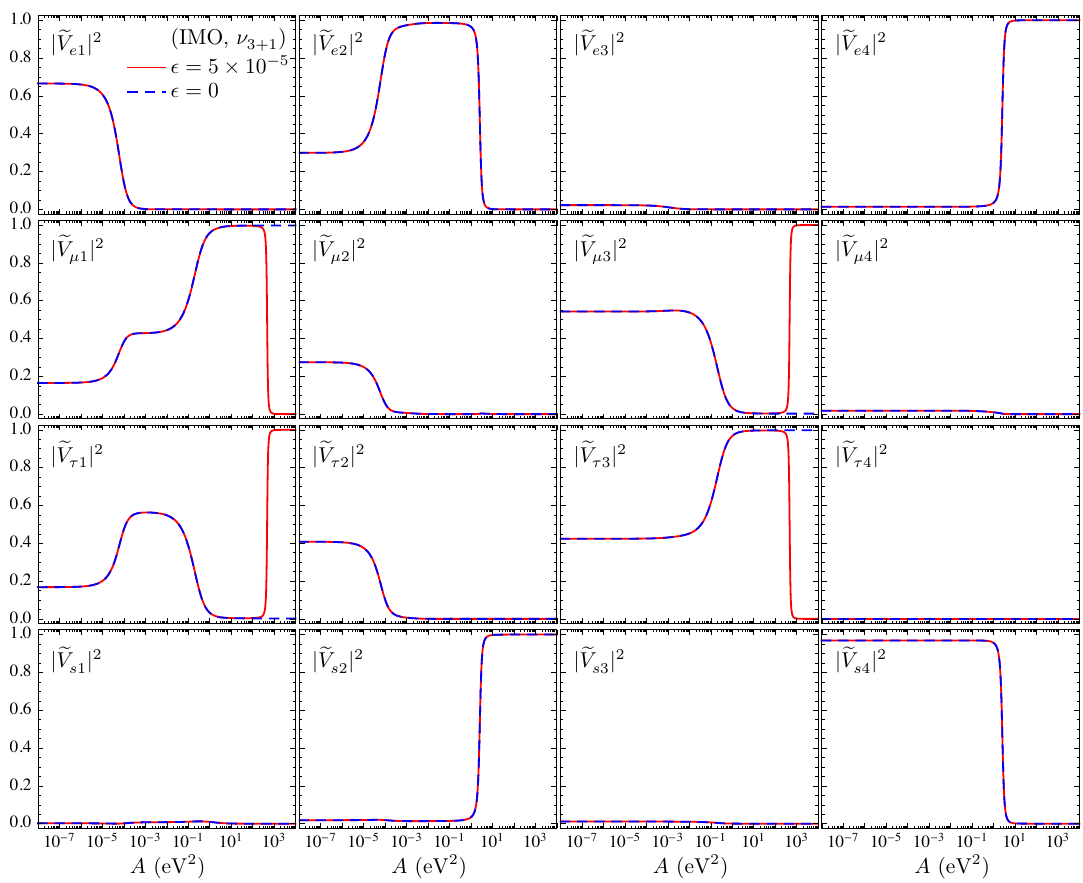
2 (for (cid:11) = e; (cid:22); (cid:28); s and i = V (cid:11)i j j ) with or without 3+1 e